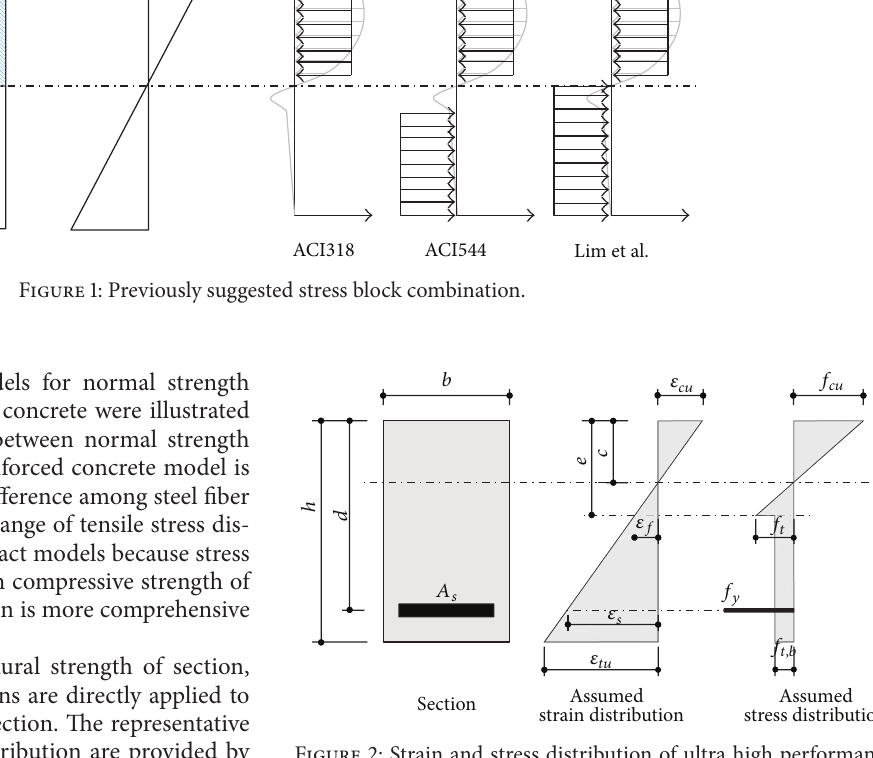
Figure 2: Strain and stress distribution of ultra high performance concrete